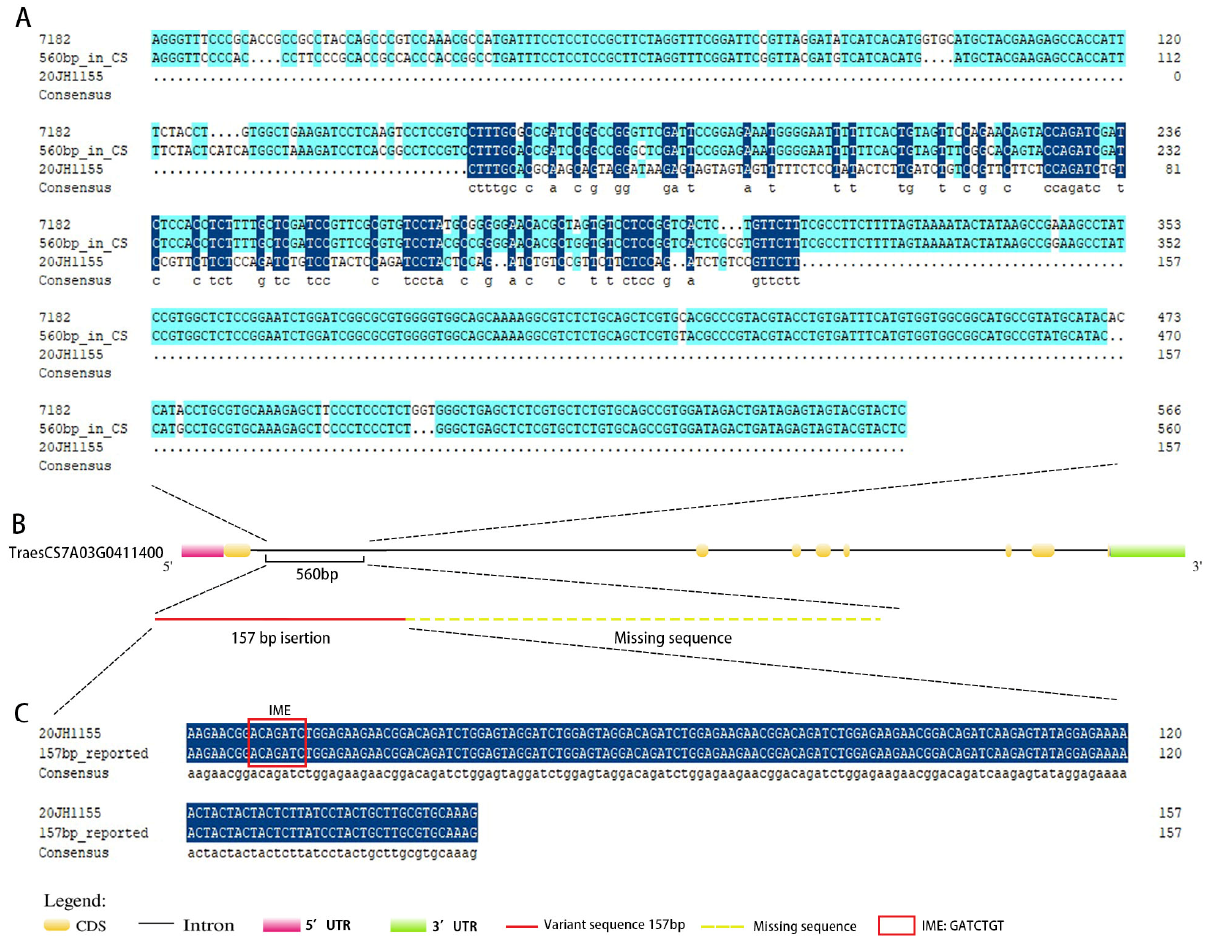
Figure 4. Sequence variation alignment of the cloning sequences of VRT-A2 . The red box marked the motif, IME. ( A ) A 560-bp comparison among 7182, 20JH1155, and TaVRT-A2 . Sequences in dark blue indicated the same bases of the three materials. The light blue showed the same bases of 7182 and Cs. ( B ) Sequence variation of TaVRT-A2 gene between 7182 and 20JH1155. ( C ) Alignment of 20JH155 and the variant 157-bp reported in T. polonicum . The dark blue meant the same sequence of the two materials.